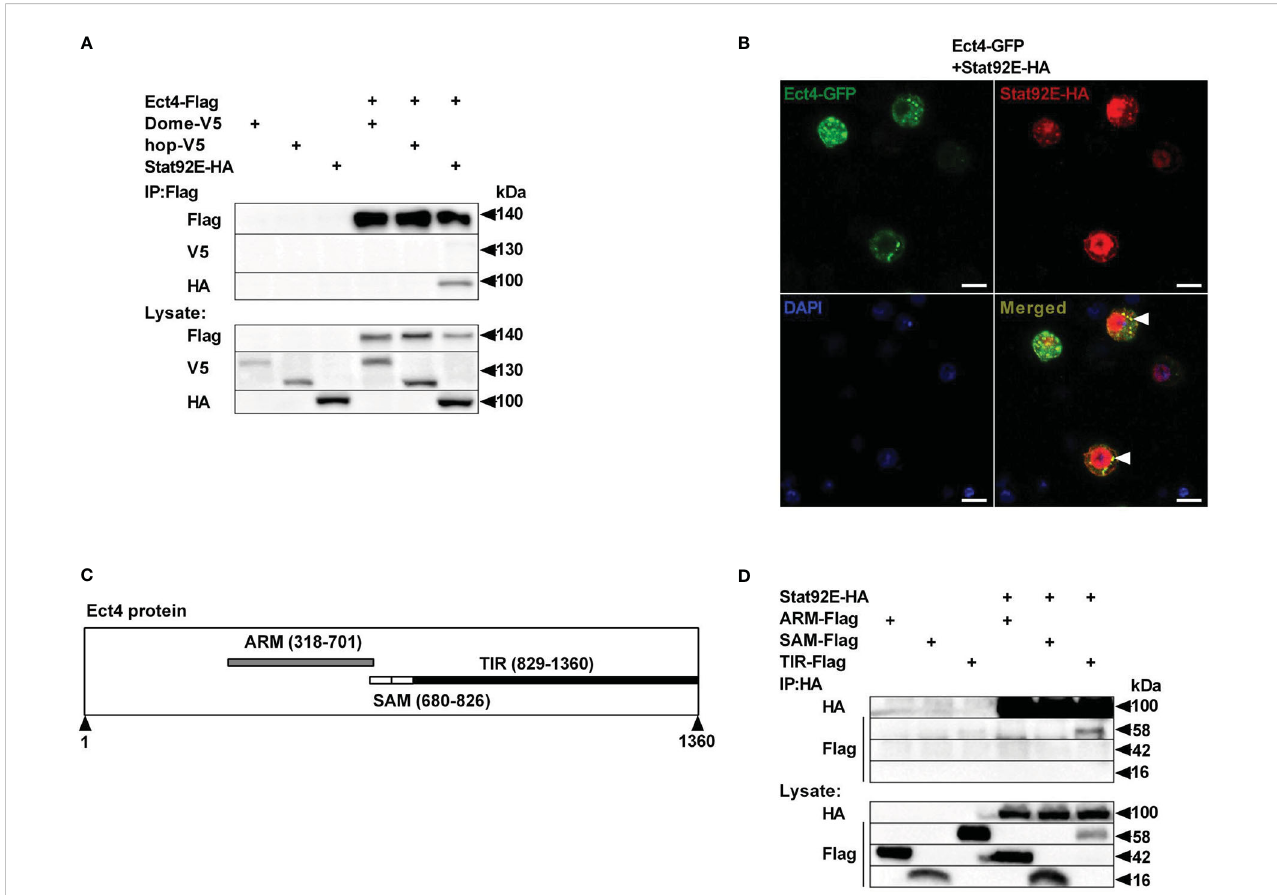
FIGURE 5 Ect4 co-localizes and physically associates with Stat92E. (A) S2 cells were transfected with combinations of expression plasmids as indicated. Cell lysates were immunoprecipitated with anti-Flag beads, followed by immunoblot analysis with the indicated antibodies. (B) S2 cells were transfected with Ect4- GFP in combination with Stat92E-HA, stained with DAPI (blue) and anti-HA antibody (Red), and imaged by confocal microscopy. Ect4 was co-localized with Stat92E in the cytoplasm (white arrow). (C) Ect4 protein includes ARM (gray), SAM (white), and TIR (black) domain. (D) S2 cells were cotransfected with Stat92E-HA and domains of Ect4. Cell lysates were immunoprecipitated with anti-HA beads and immunoblot analysis with the indicated antibodies. Scale bar: 10 m